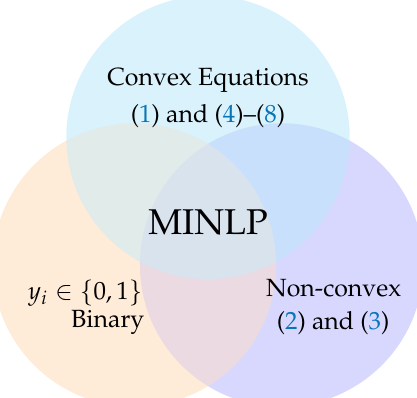
Figure 1. Characterization of the mathematical model associated with the optimal location and sizing of DGsin DC